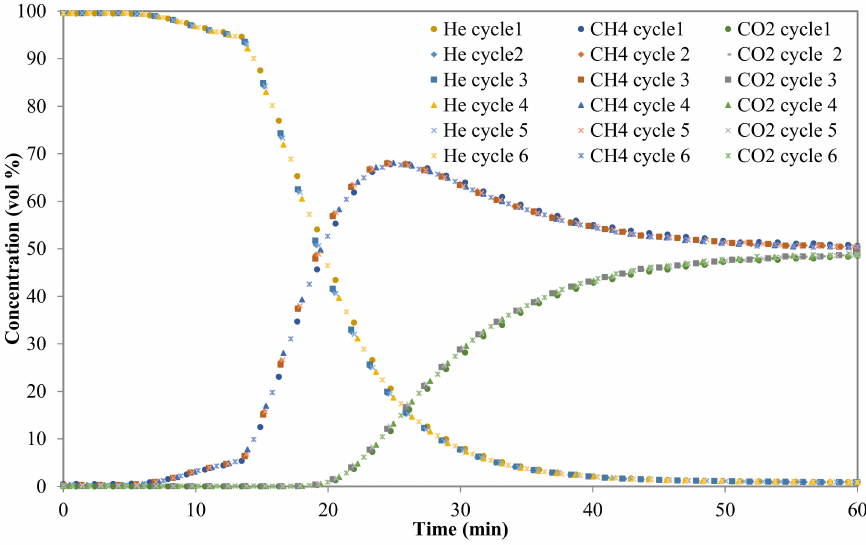
Figure 7. Breakthrough curves for a 50/50 vol % CO 2 /CH 4 binary gas mixture at 1 bar. (Symbols represent CO 2 and CH 4 concentrations for different